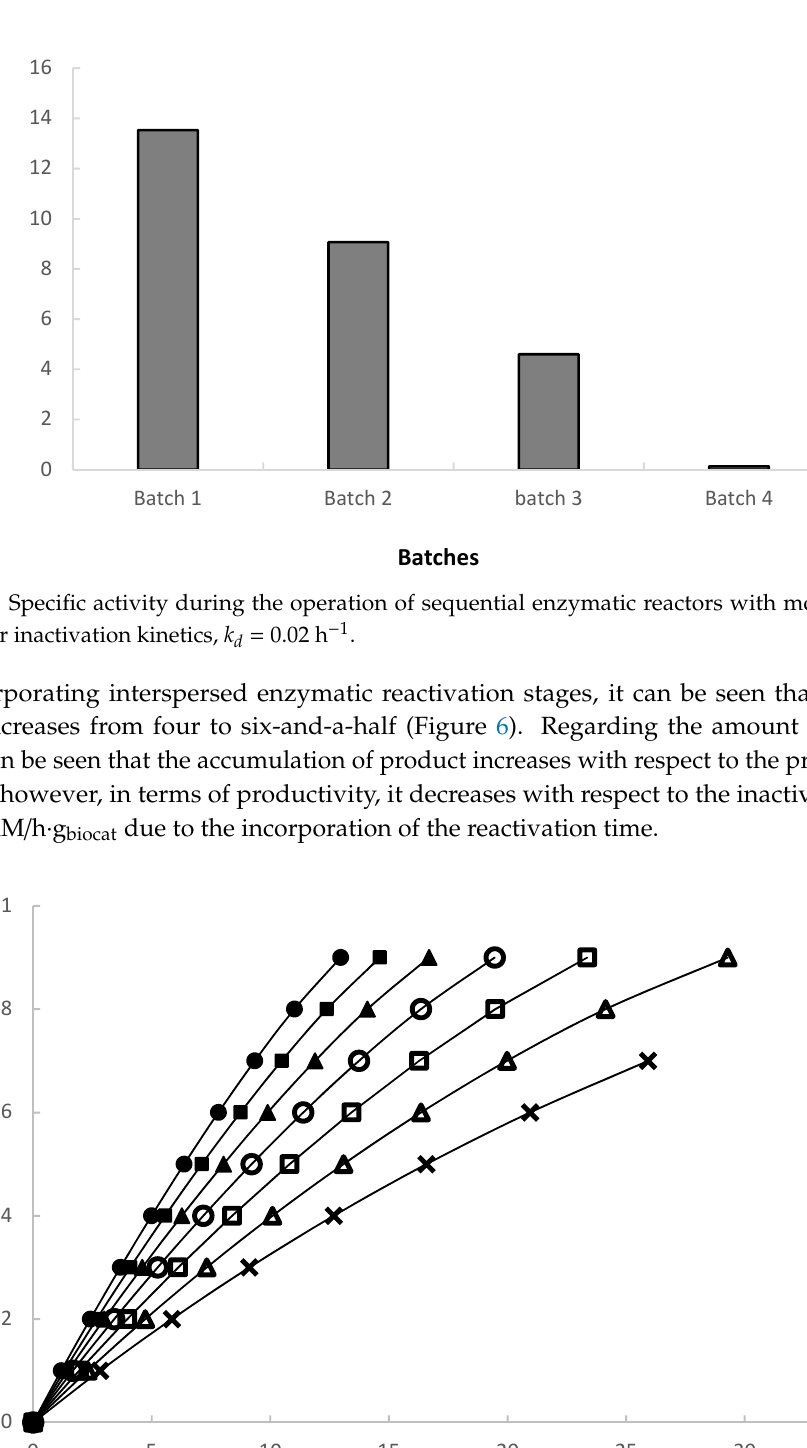
Figure 7. Product and specific global productivity over time, during the operation of the successive batch enzyme reactor with monophasic first-order inactivation kinetics, k d = 0.022 h and reactivation k r = 0.1 h –1 . Black line—Product (mM); Red line—Global specific productivity (mM/h·g biocat ).